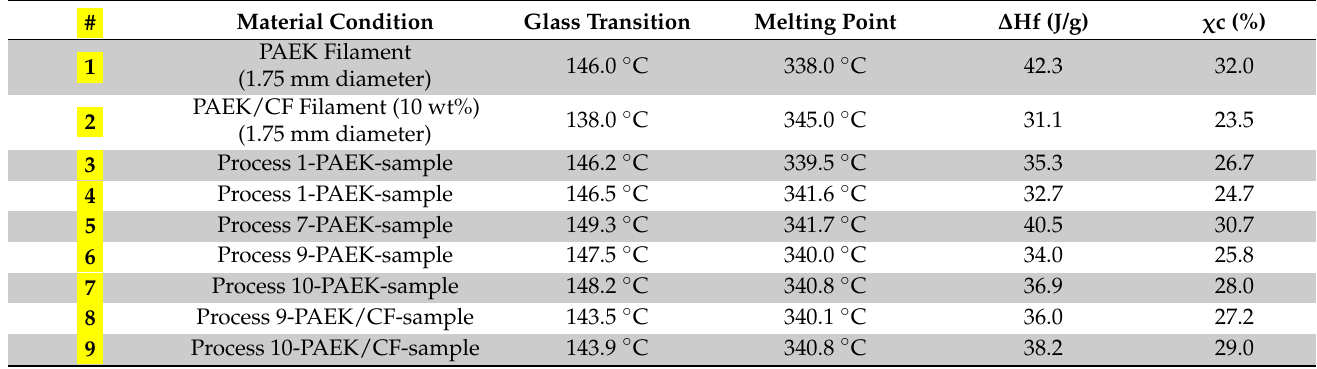
Table 3. Average thermal transitions and enthalpies for PAEK and PAEK/CF and their thermal history under different processing conditions. All samples were manufactured with oven temperature of 160 ◦ C, except process 4, for which the oven temperature was 180 ◦